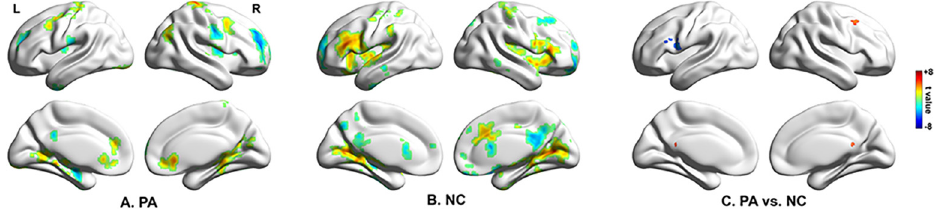
Fig 2. Voxel-wise GCA. (A) Regions showing significant causal effect with the seed in patients. (B) Regions showing significant causal effect with the seed in controls. (C) Regions showing abnormal causal effect with the seed in patients compared with controls. Color bar represents t values. NC = normal control; PA = patient.